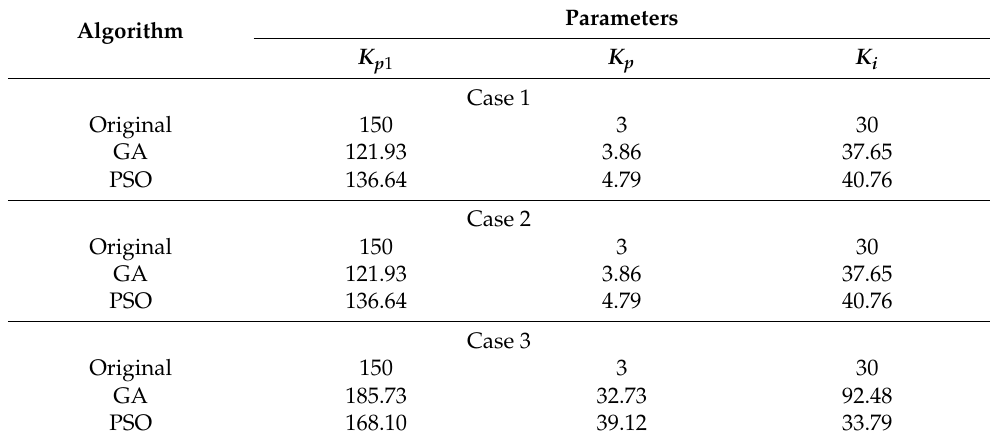
Table 2. P and PI controllers’ parameter values: original and optimized by the GA and PSO algorithms.